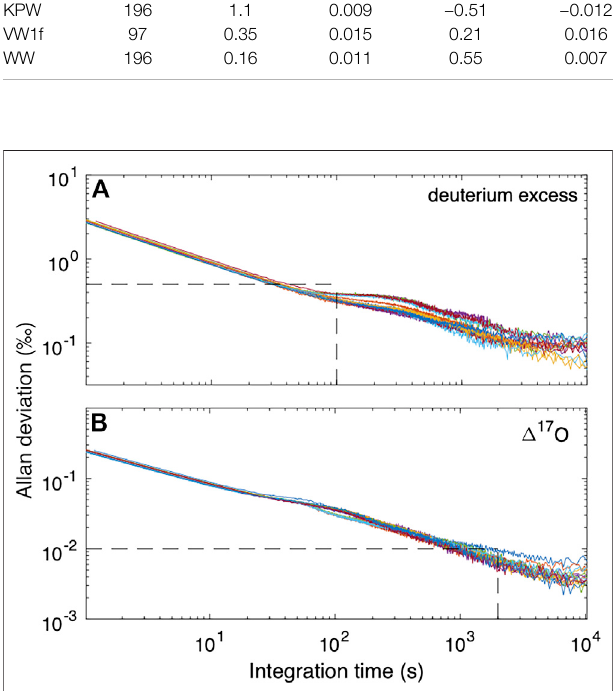
FIGURE 4 | Allan deviation for (A) d (deuterium excess) and (B) Δ 17 O from reference water measurements using the CFA system. Dashed lines in (A) show that for integration times of 100 s, precision for d is less than 0.5 ‰ . For Δ 17 O,longermeasurementtimesarerequired.Verticaldashedlinein (B) is at 2000 s, corresponding to Δ 17 O precision < 0.01 ‰ (10 per